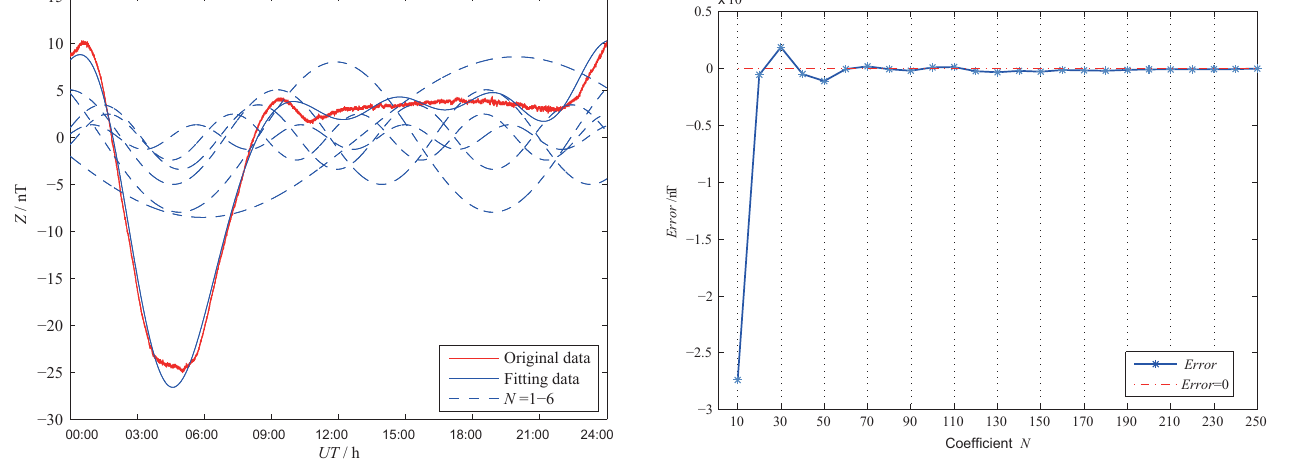
Figure 2. Error results of 10th–250th harmonic components. harmonic components. The residual error (Error in Eq. 3) be-